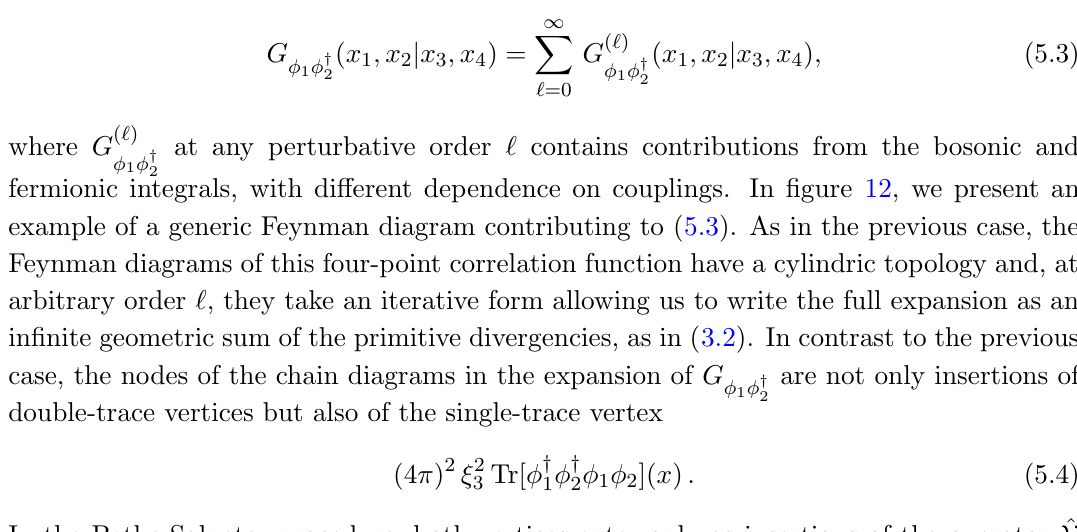
Figure 12 . A Feynman diagram contributing to the perturbative expansion G ( ‘ ) squares and dots stand for single- and double-trace vertices respectively. Tick lines are bosonic propagators and dashed lines fermionic ones. The colors represent di(cid:11)erent (cid:13)avors j of the particles (cid:30) j and j : in particular black for j = 1, red for j = 2 and green for j = 3. The propagators are not crossing and are curved to stress the fact that they have a cylindrical